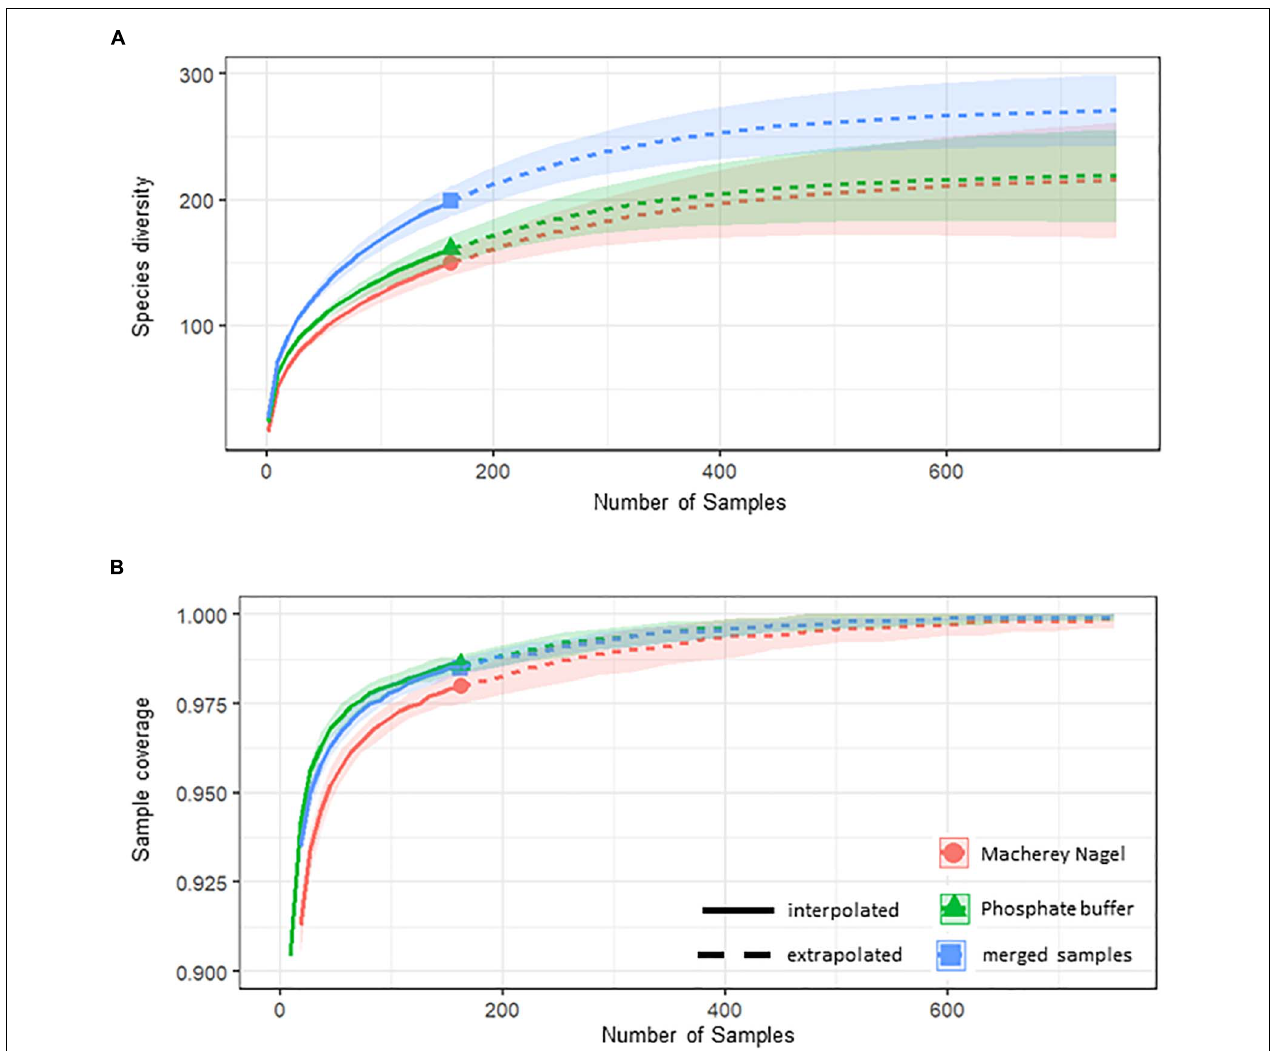
FIGURE 4 | Sample completeness curves (solid line) with extrapolation (dashed line) showing number of detected arthropod species (blastID ≥ 99%) with both markers per number of soil samples taken for each extraction method (A) . Additionally, sample coverage curves were calculated based on sample coverage per number of soil samples (B)